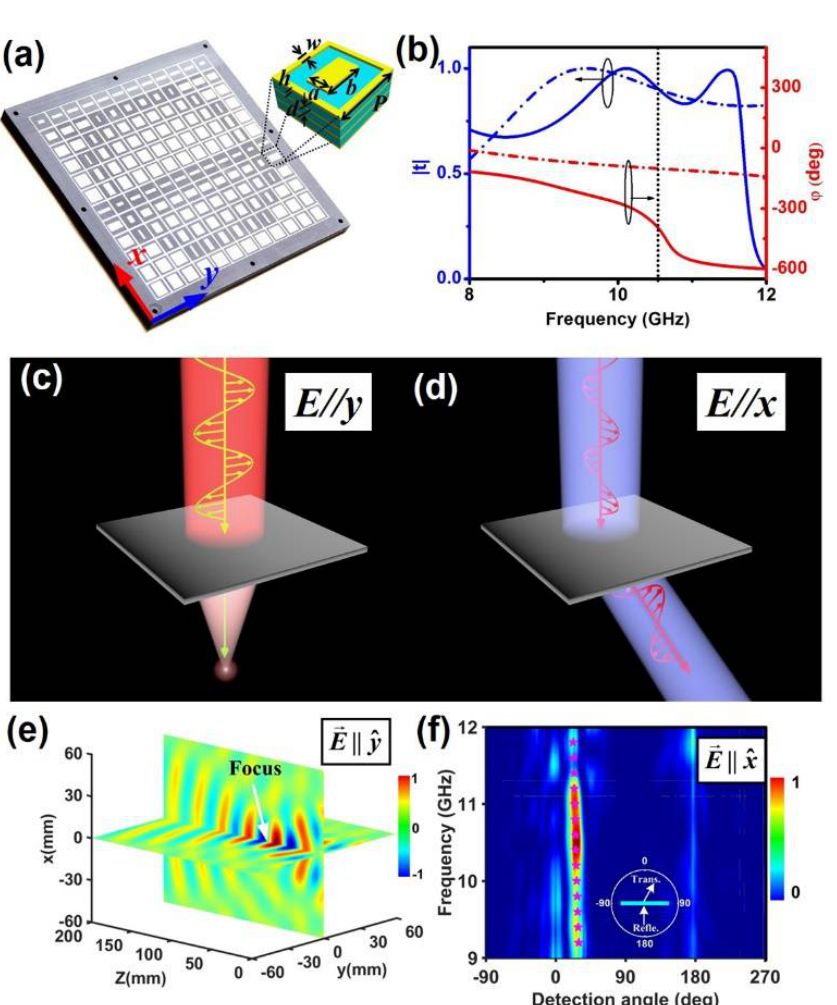
Figure 6. ( a ) Photograph of a microwave transmissive bifunctional metasurface. Inset illustrates a typical meta-atom composed by four metallic layers (yellow) separated by three F4B spacers (blue). ( b ) Transmission amplitude (blue lines) and phase (red lines) for a periodic metasurface constructed by the 4-layer meta-atom, under the excitations of y -polarized (solid lines) and x -polarized (dotted lines) incident waves, respectively. Schematics and working principles of a transmissive bifunctional metasurfaces, which behaves as ( c ) a focusing lens and ( d ) a beam deflector when excited by incident waves with polarizations E // y and E // x , respectively. ( e ) Measured Re[E ] distributions on both x o z and y o z planes as the metasurface is illuminated by a normally-incident y -polarized plane wave. ( f ) Measured scattered wave intensity as function of frequency and detection angle when the metasurface is illuminated by x -polarized normally incident plane waves. Reproduced from [93] with